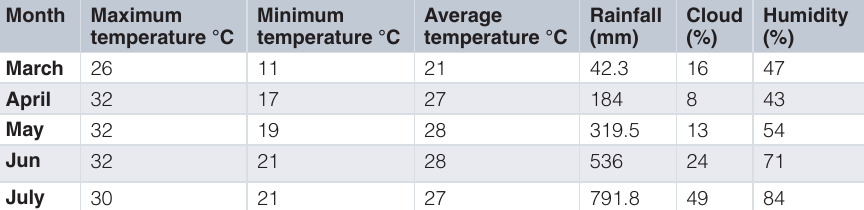
Table 3. Data on average weather over the study